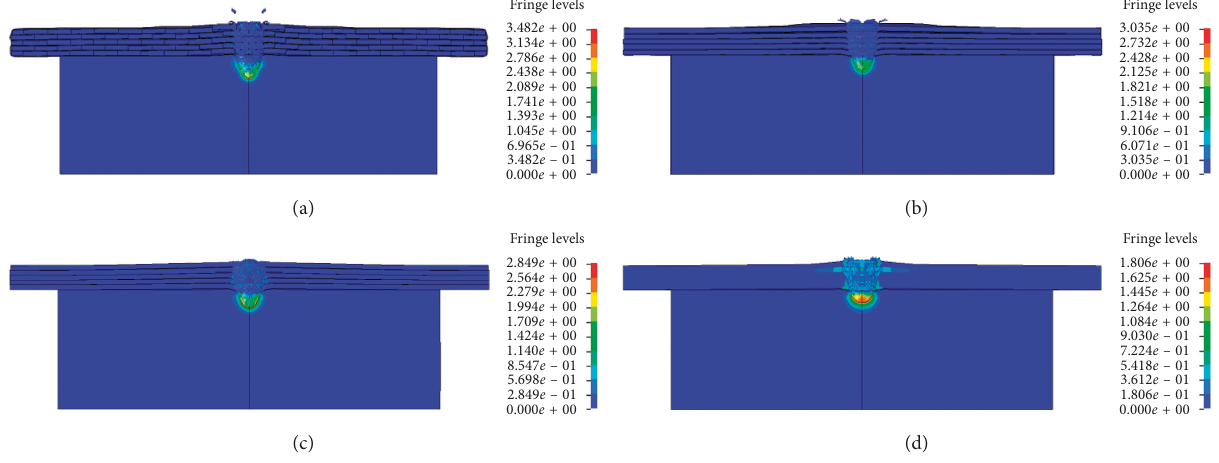
Figure 18: Damage of FC-RPC target 2 by different models: (a) result of Model A; (b) result of Model B1; (c) result of Model B2; (d) result of Model